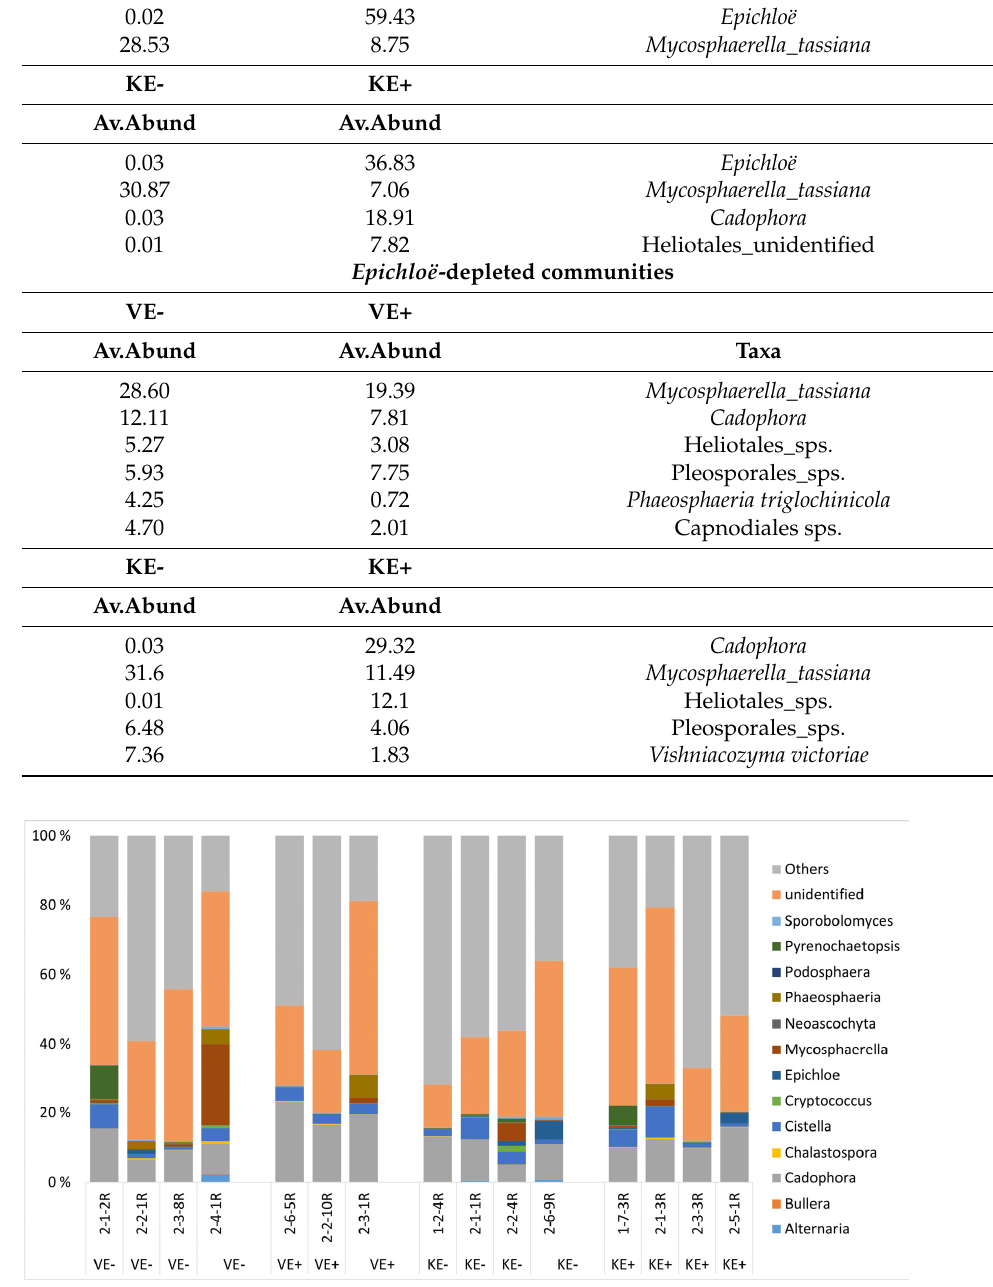
Figure 4. Taxonomic distribution of fungal communities at the genus level in the Epichloë -symbiotic (E+) and Epichloë -free (E-) roots of ‘Valtteri’ (V) and ‘Kasper’ (K) cultivars of meadow fescue ( Festuca pratensis ).